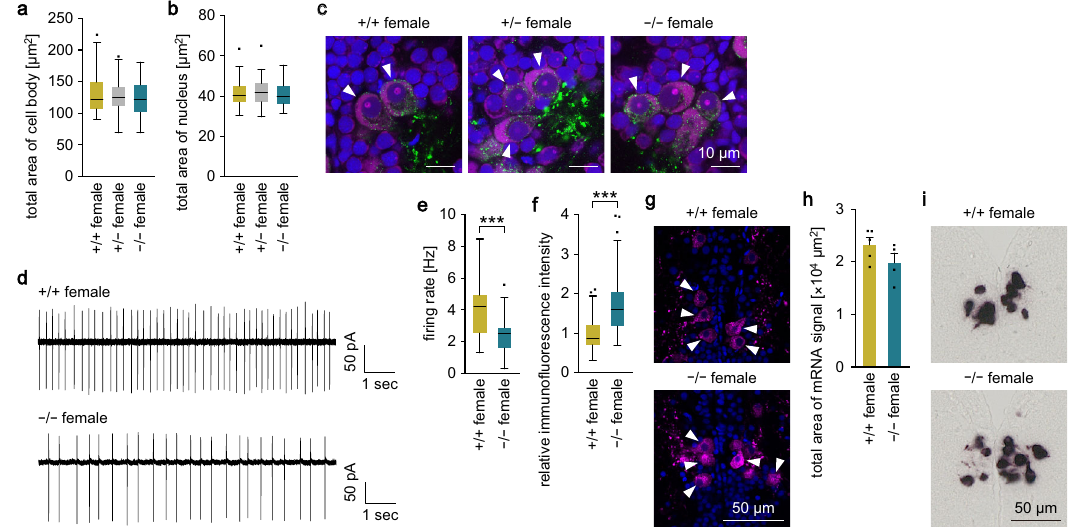
Fig. 6 ptger4b de fi ciency reduces fi ring activity and impairs neuropeptide release in FeSP neurons. Cellular phenotypes of FeSP neurons in the PMm/ PMg were analyzed in females of the Δ 17 line. Cell body size ( a ) and nuclear size ( b ) of FeSP neurons in ptger4b + / + , ptger4b + / − , and ptger4b − / − females ( n = 50 neurons from 5 individuals for each genotype). c Representative micrographs showing the morphology of FeSP neurons (arrowheads) in ptger4b + / + , ptger4b + / − , and ptger4b − / − females. Npba immunolabeling is shown in green; Nissl-stained cell bodies in magenta; and DAPI-stained nuclei in blue. Scale bars represent 10 μ m. d Representative fi ring patterns of FeSP neurons in ptger4b + / + and ptger4b − / − females. e Firing frequencies of FeSP neurons in ptger4b + / + ( n = 21 neurons from 10 individuals) and ptger4b − / − ( n = 25 neurons from 14 individuals) females. f Relative immuno fl uorescence intensity of Npba in FeSP neurons of ptger4b + / + ( n = 54 neurons from three individuals) and ptger4b − / − ( n = 98 neurons from three individuals) females. g Representative micrographs showing Npba immunolabeling (magenta) in FeSP neurons (arrowheads) of ptger4b + / + and ptger4b − / − females. DAPI- stained nuclei are shown in blue. Scale bars represent 50 µ m. h Total area of npba mRNA signal in the PMm/PMg of ptger4b + / + ( n = 5) and ptger4b − / − ( n = 4) females. i Representative micrographs showing npba mRNA signal in the PMm/PMg of ptger4b + / + and ptger4b − / − females. Scale bars represent 50 µ m. Quantitative data were expressed as box-and-whisker plots ( a , b , e , f ) or means with error bars representing standard error of the mean ( h ). Statistical differences were assessed by Bonferroni ’ s post hoc test ( a , b ), unpaired t -test ( e , h ), and unpaired t -test with Welch ’ s correction ( f ). *** p <